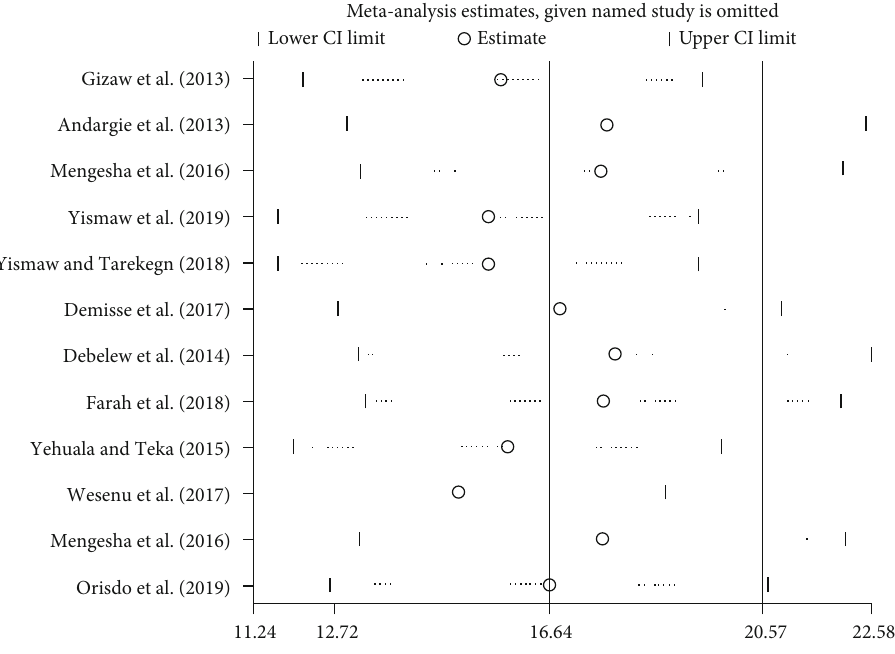
Figure 8: Result of sensitivity analysis of the 24